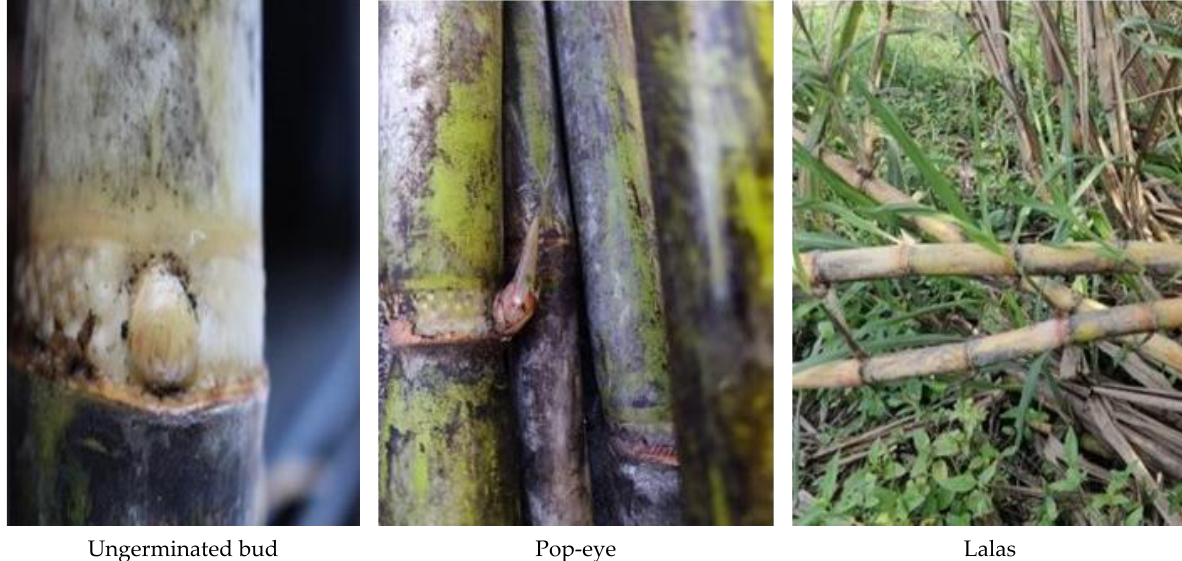
Figure 1. Sugarcane bud germination levels used for the experiment.